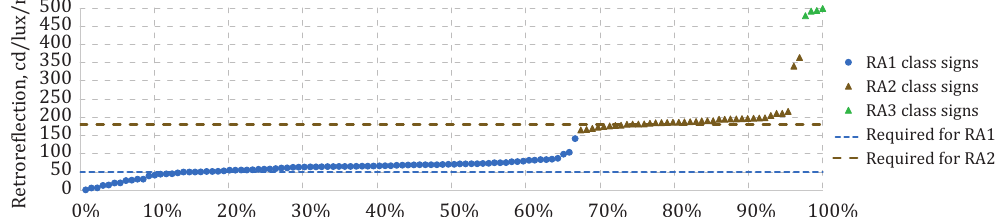
Figure 8. Traffic sign retroreflection coefficient for the white colour